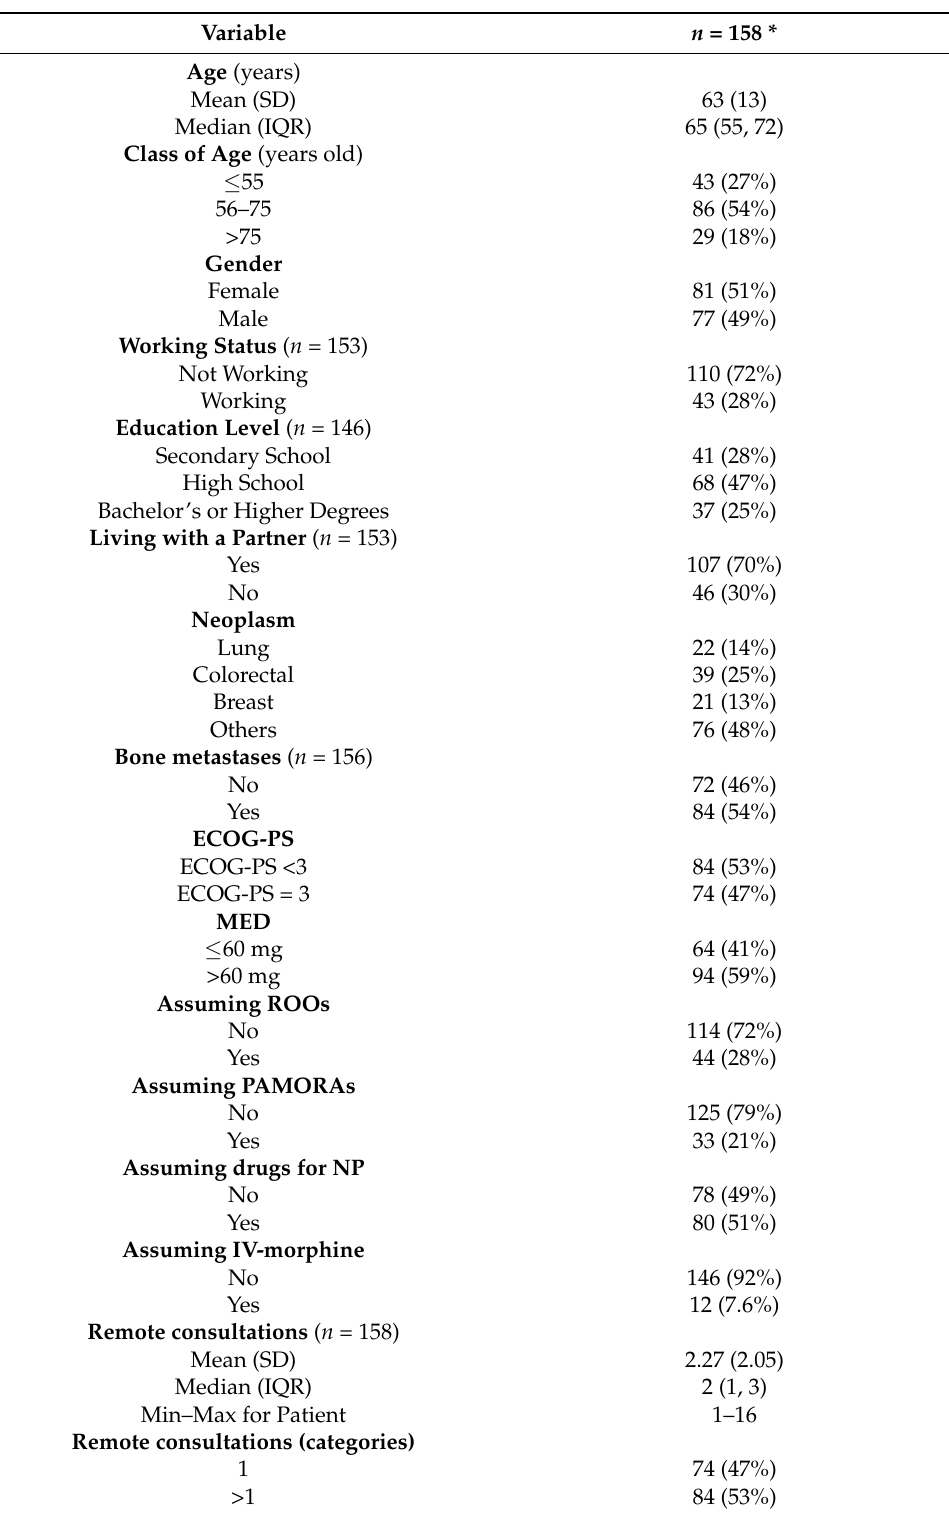
Table 2. Data from the considered